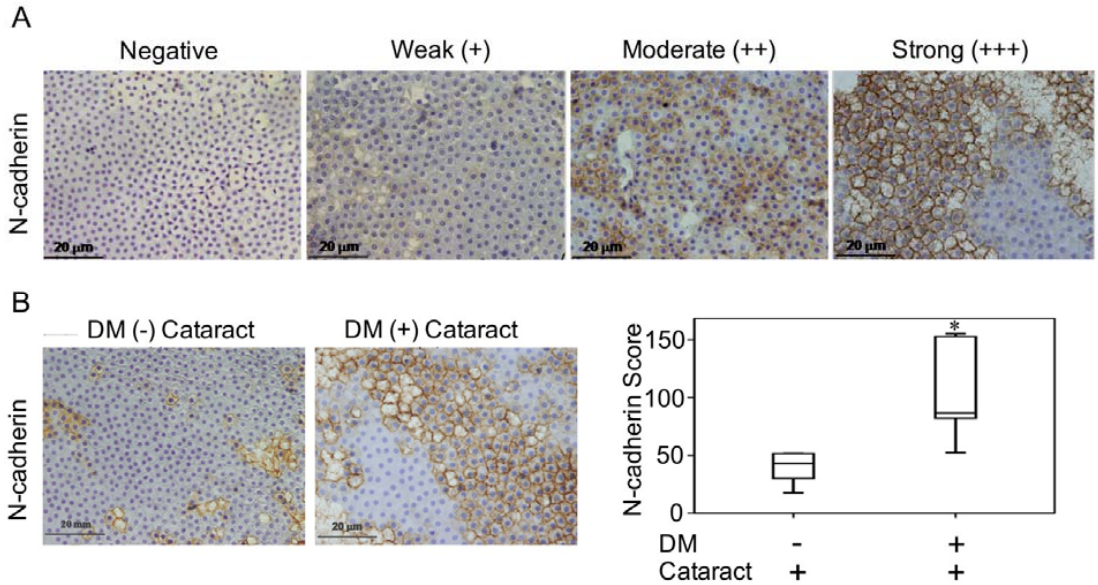
Figure 1. N-cadherin in diabetes mellitus (DM) ( + ) and DM ( − ) cataract patients. ( A ) Representative photomicrographs of cataract samples with N-cadherin labeled to score negative ( − ), weak ( + ), moderate ( ++ ), and strong ( +++ ) expressions and the pathological phase of the cataracts (phase 1-4). ( B ) In DM ( + ) cataract patients, N-cadherin expression levels were higher than those in DM ( − ) cataract patients ( p = 0.040). ( C ) Box plot of N-cadherin expression levels in DM ( + ) and DM ( − ) cataract patients. The presented values are the mean ± SEM ( n = 10 per group, separate experimental groups in each figure). * p < 0.05.